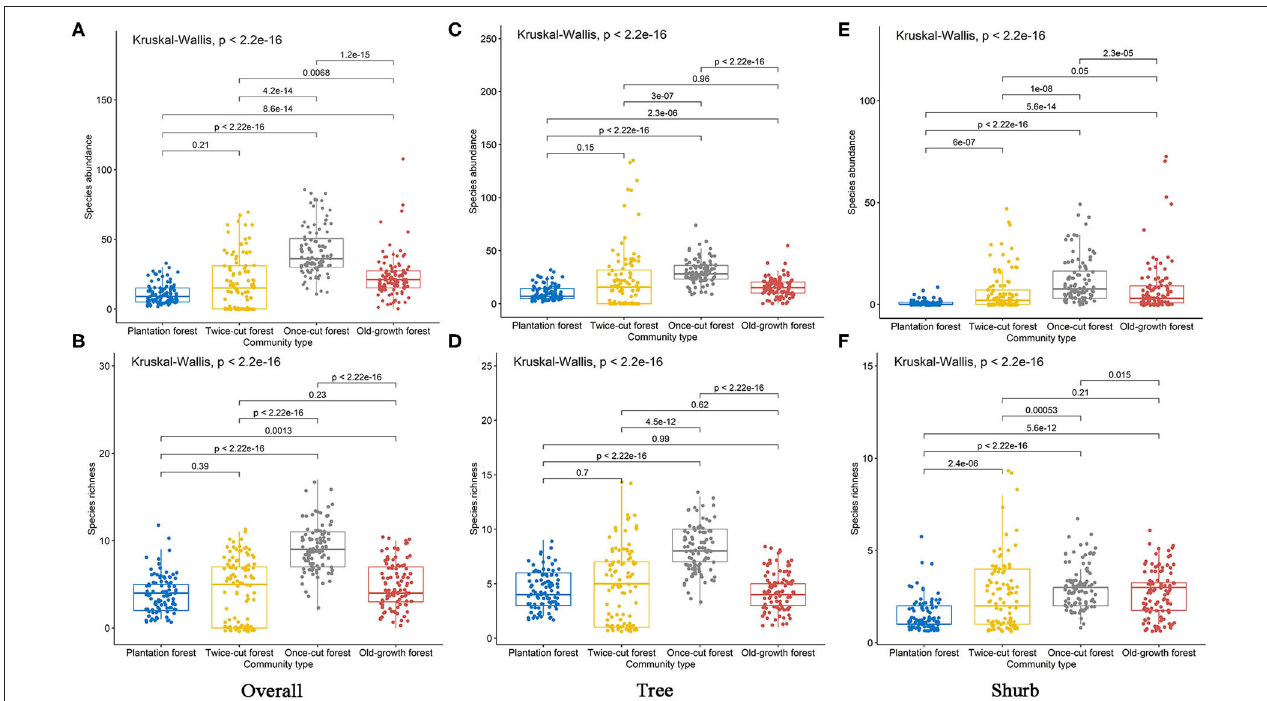
FIGURE 4 | Species richness and abundance of woody plants in the four communities. Black lines indicate significant differences, as obtained using Kruskal–Wallis method ( p ≤ 0.05 level of significance). (A,B) are the abundance and richness of overall species, respectively. (C,D) are the abundance and richness of trees, respectively. (E,F) are the abundance and richness of shurbs, respectively.